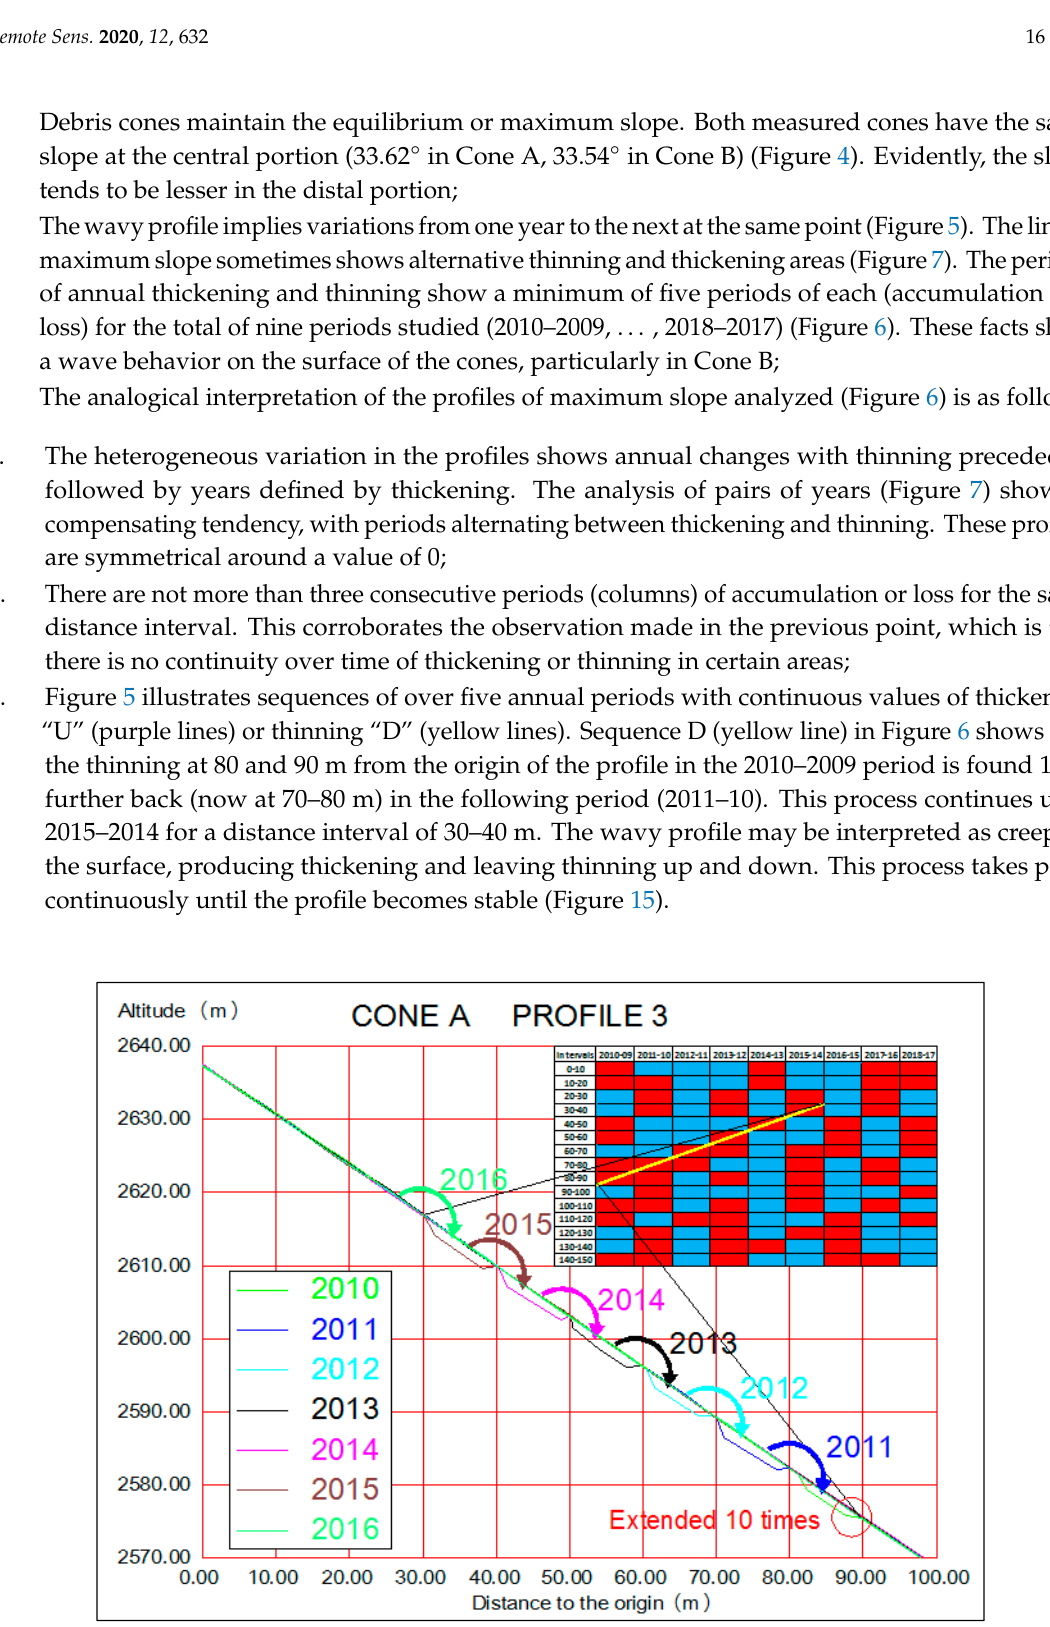
Figure 16. Profile indicating the thickening in retreat over a period of 5 years (2010–14). The thickening effect in the profile is amplified x10.